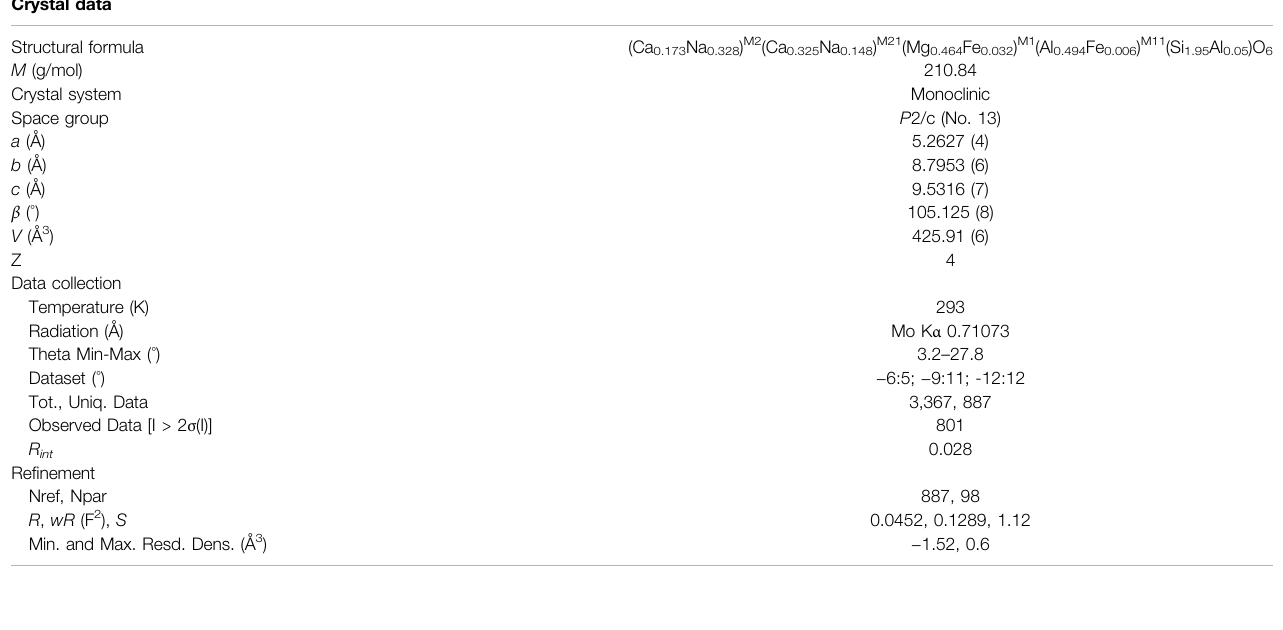
TABLE 1 | Data collection and details of the structure re fi nement for omphacite.